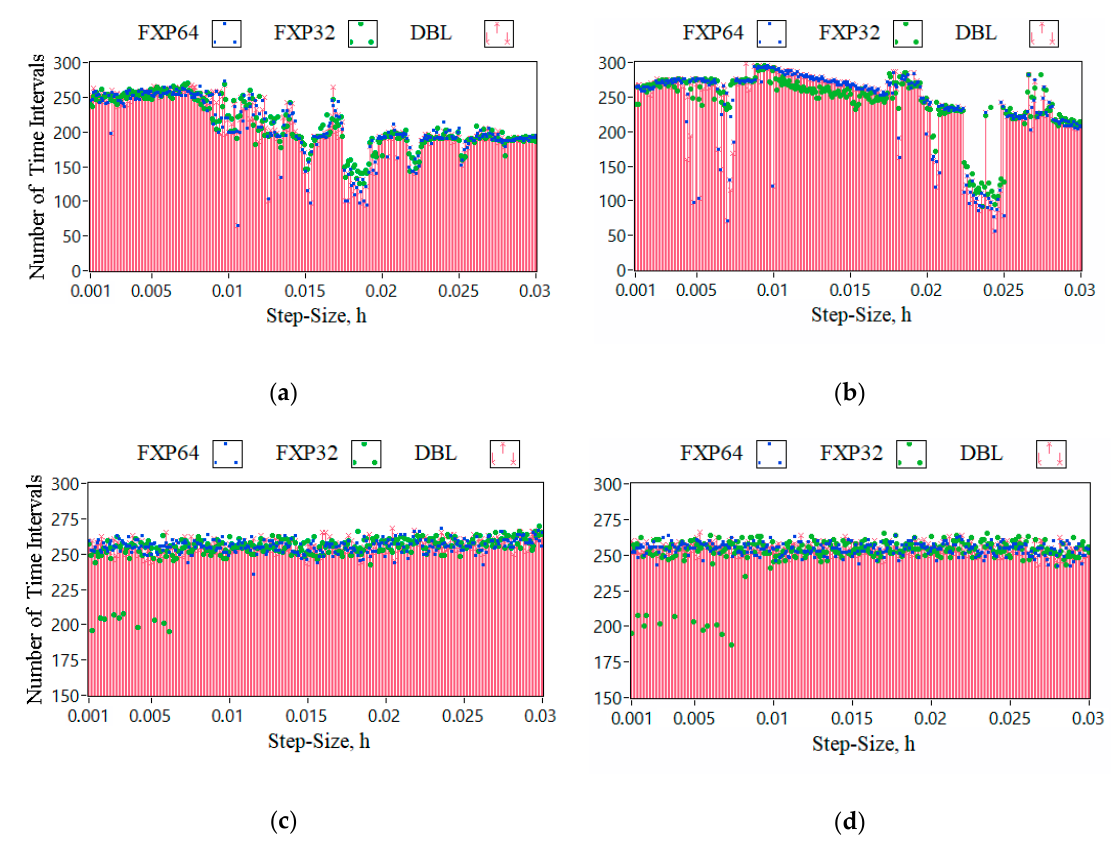
Figure 12. The numbers of interspike intervals for 32-bit FXP, 64-bit FXP, and DBL solvers obtained by the methods ( а ) EE, ( b ) SEE, ( c ) EMP, and ( d ) MEMP.